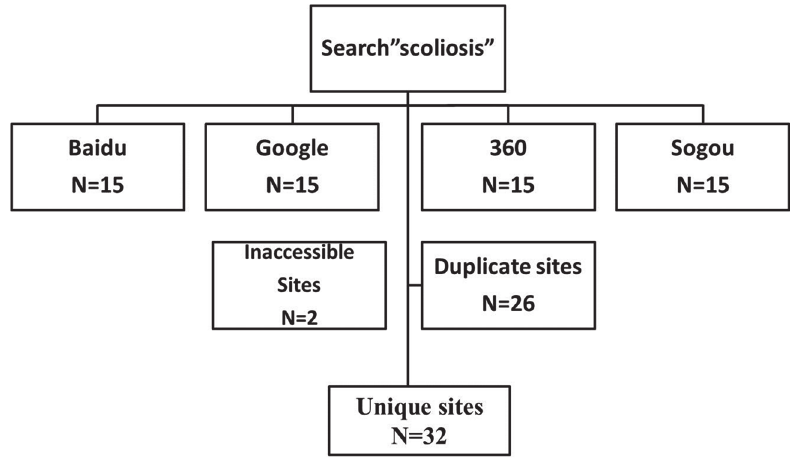
Fig 1. Flow chart of website search using the four most popular search engines.